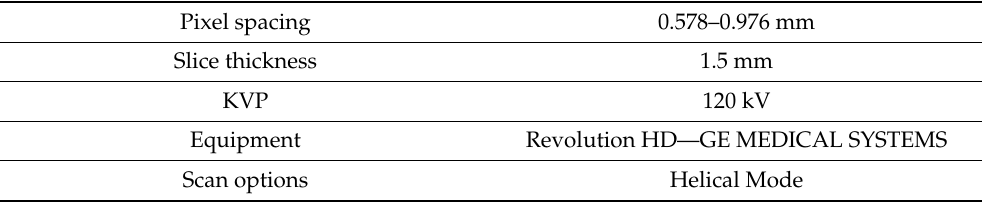
Table 1. CT equipment and acquisition